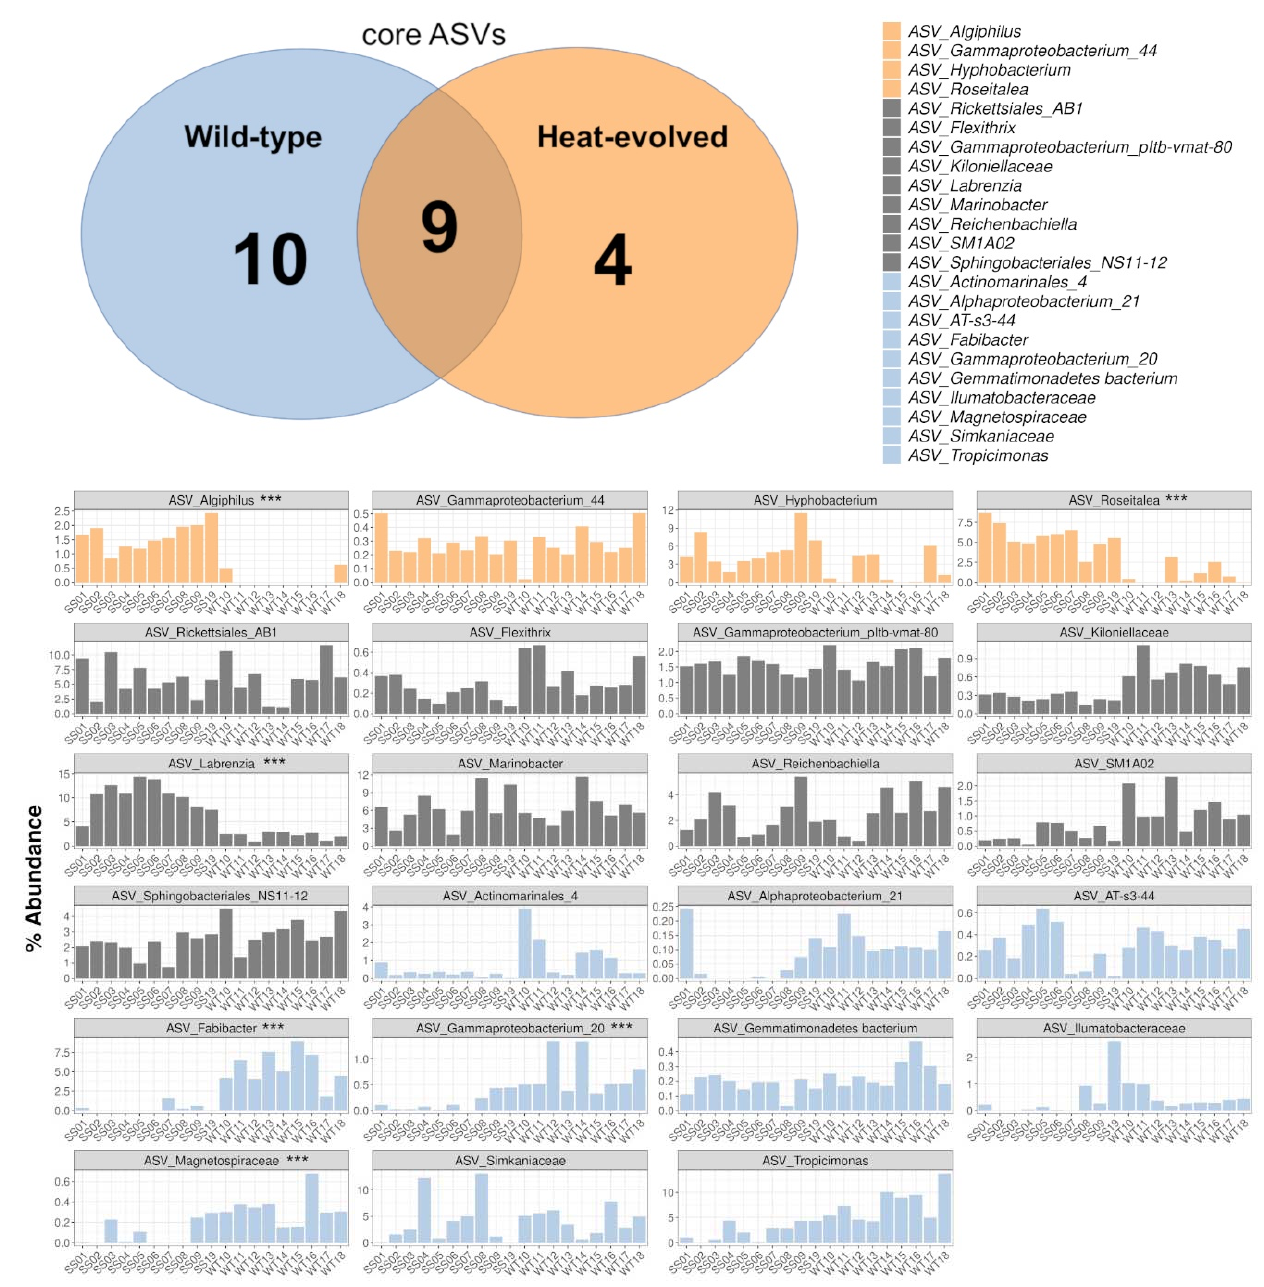
Figure 5. Core taxa in heat ‐ evolved strains (SS) and wild ‐ type (WT) strains. The Venn diagram shows the number of core ASVs for each strain group and the number of shared core ASVs across strains. Relative abundances are shown as bar plots for the core ASVs of the WT and SS strains. The color coding is indicative for the strain group in which the core ASV is detected (orange: SS strains; grey: shared core taxa between SS and WT; blue: WT strains). The three stars (***) next to the ASV genus assignment indicate a significantly different abundance between the WT and SS strains through the DESeq2 analysis, at significance threshold <0.001.